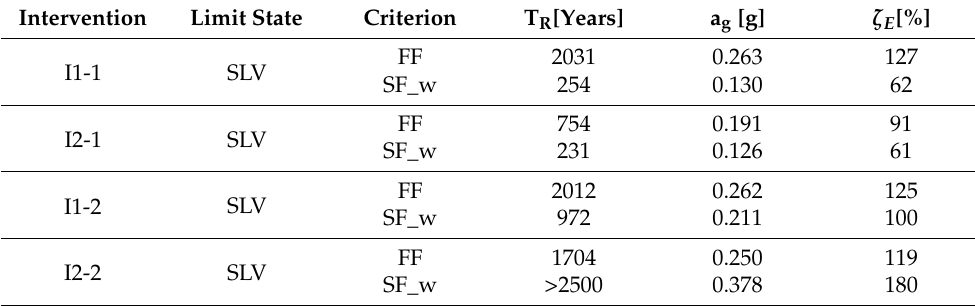
Table 16. Seismic performance indices for each retrofitting intervention. Intervention Limit State Criterion